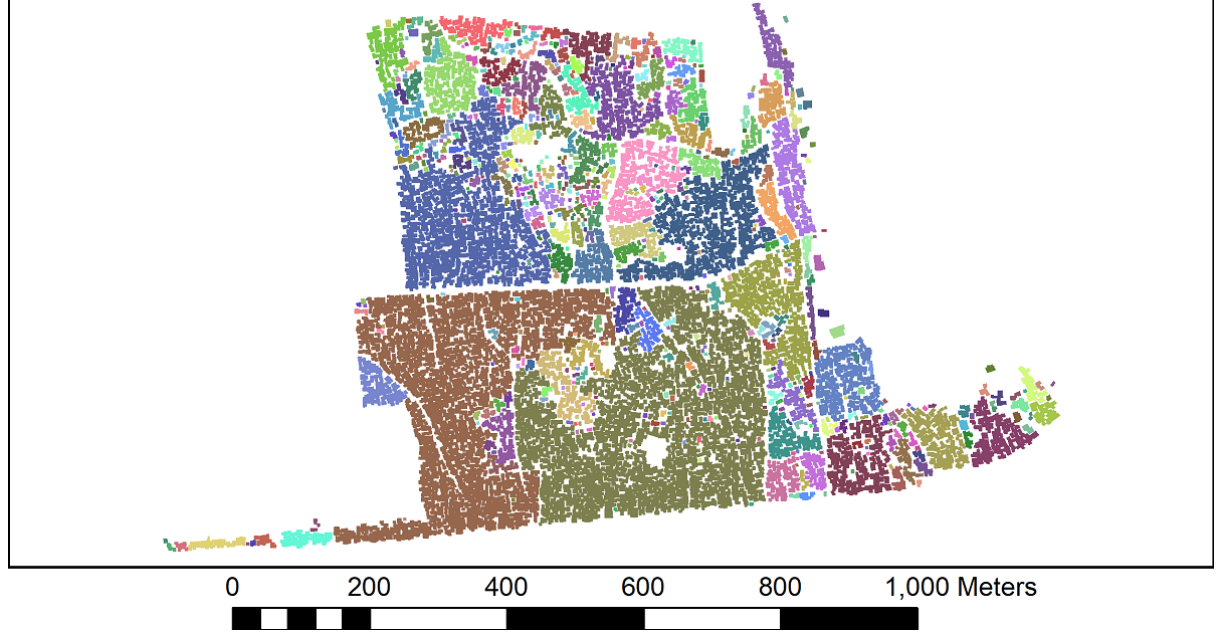
Figure 6. The clusters of dwellings in Klipfontein Glebe that would need to self-isolate together. Different colors indicate group of dwellings that will be unable to practice social distancing from neighbors within the same color cluster.